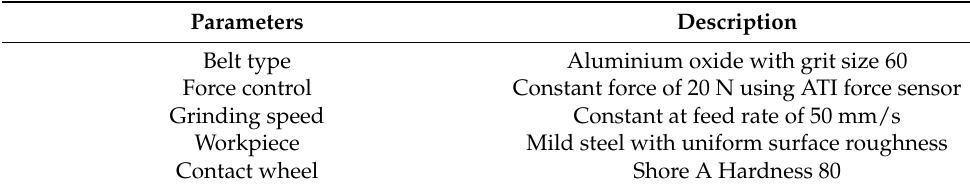
Figure 13. A customized abrasive belt-grinding experiment and sensors position (accelerometer and dynamometer). Table 1. Experimental